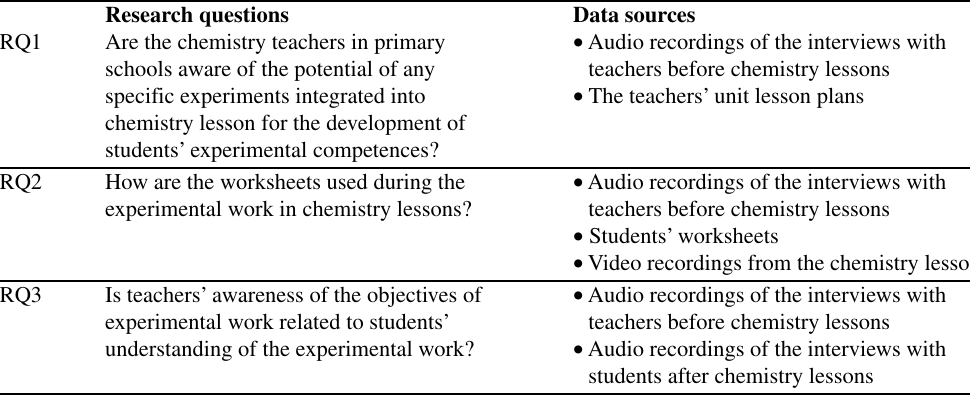
Table 1: Research questions and data sources